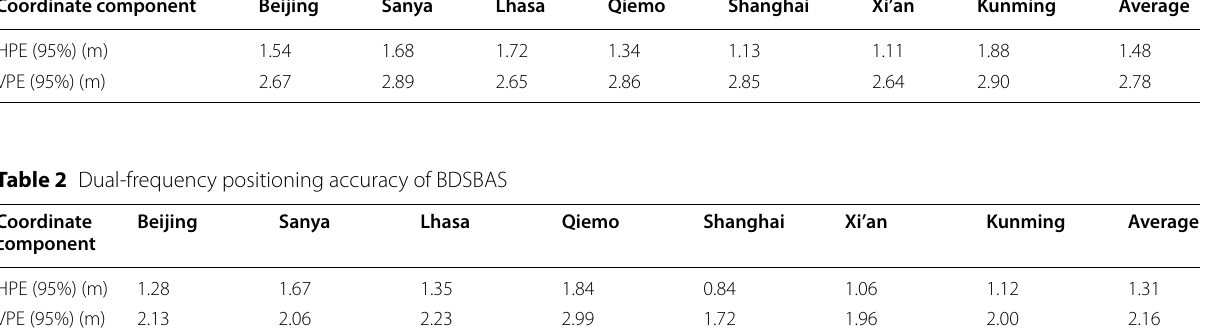
Table 1 Single-frequency positioning accuracy of BDSBAS Coordinate component